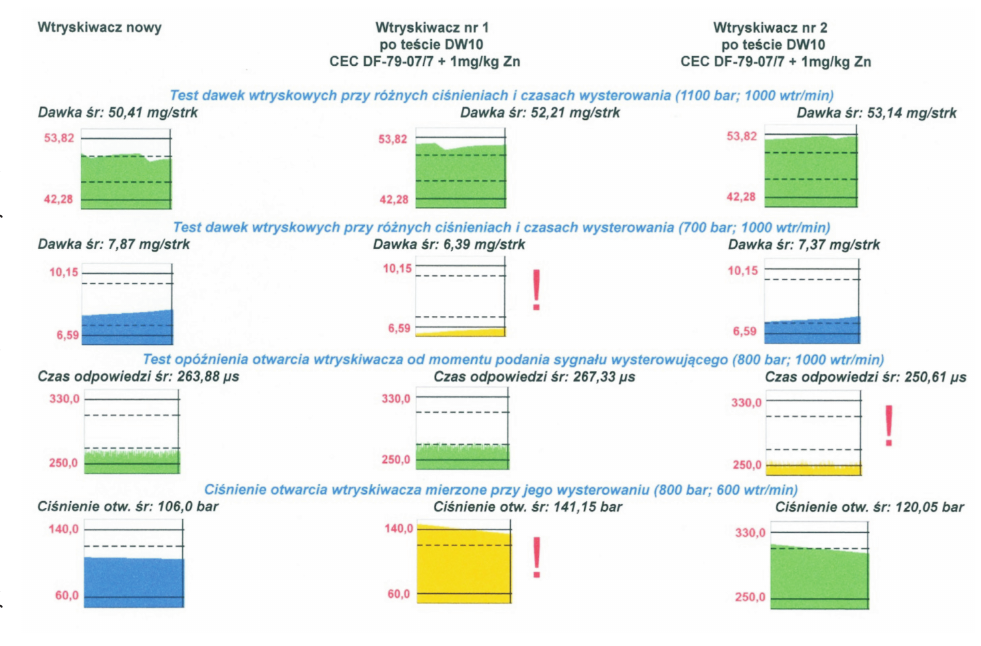
Fig. 10. Results of the assessment of selected diagnostic parameters of the fuel